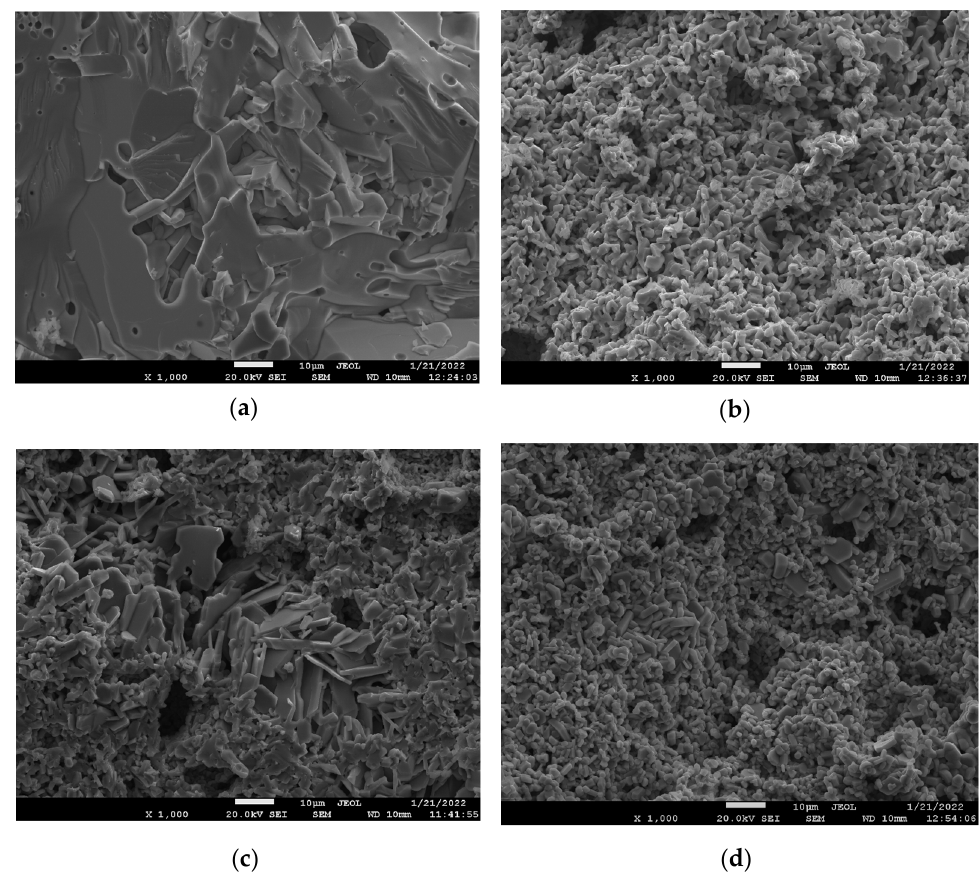
Figure 3. Scanning electron images of ceramic fracture for composition samples ( a ) BaFe 5.84 Ga 6.16 O 19 , ( b ) BaFe 6.26 Al 2.27 Cr 3.47 O 19 , ( c ) BaFe 6.11 Al 1.56 Cr 2.17 Ga 2.16 O 19 , ( d ) BaFe 6.19 Al 1.25 Cr 1.57 Ga 1.74 In 1.26 O 19 .